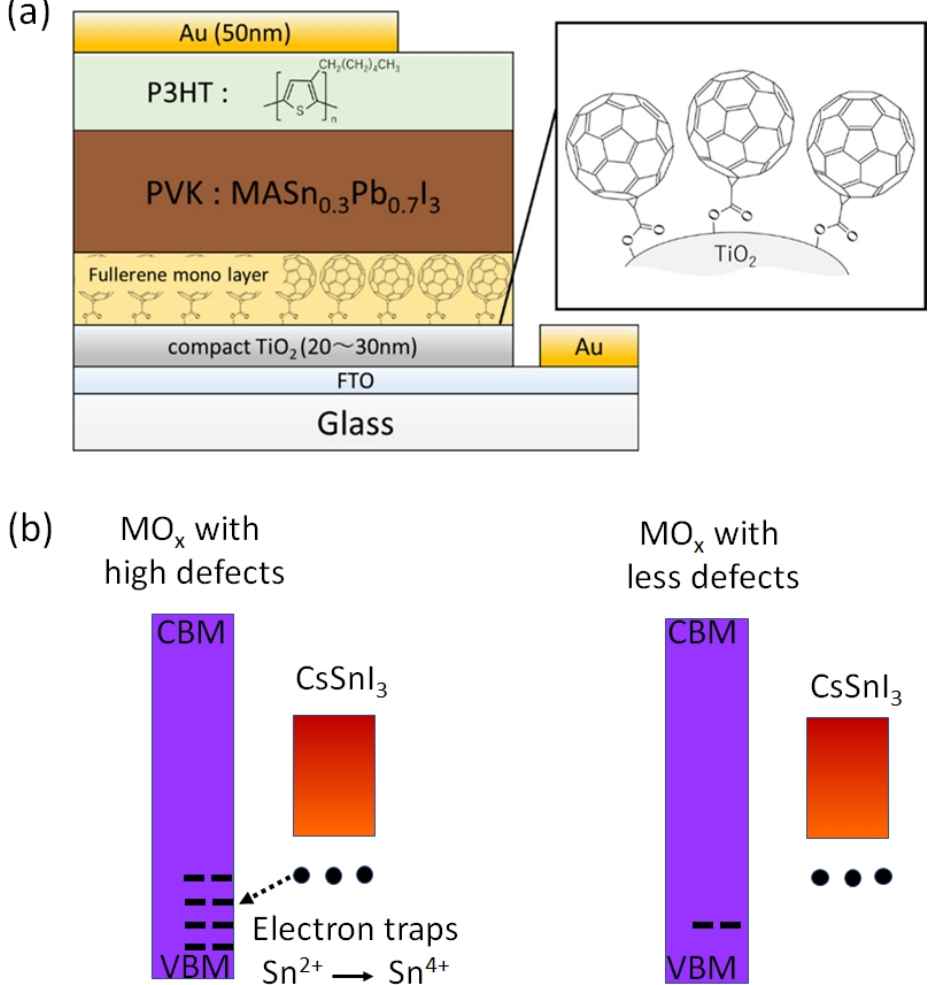
Figure 12. ( a ) The interlayer of C60-COOH was used to avoid the effect of acceptor defects of the TiO 2 layer. Reprinted with permission from [73]. Copyright 2020, American Chemical Society. ( b ) Mechanism of oxidation of Sn-PVK resulting in short-circuiting or poor rectification behavior, in normal structure solar cells. MOx represents metal oxide. Reprinted with permission from [40]. Copyright 2022, American Chemical Society.